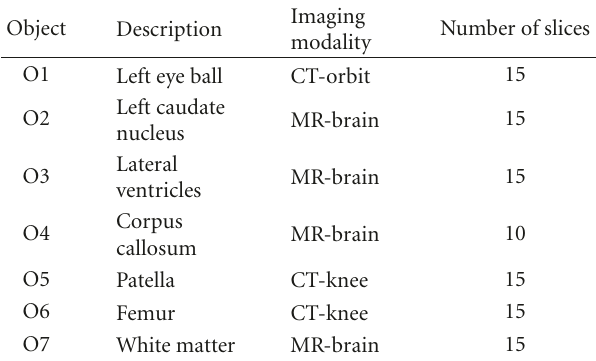
Table 1: Description, imaging modality, and number of slices for each object used in the